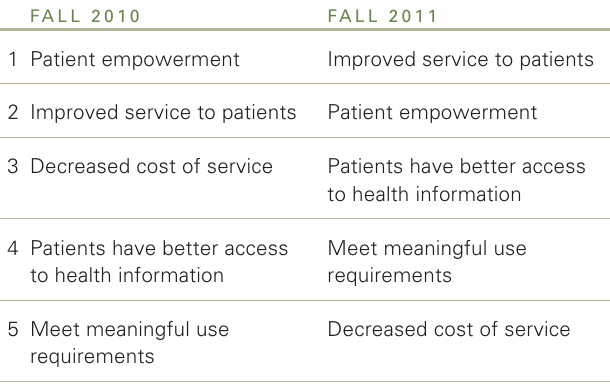
table 1. Key Motivators for Patient Portal